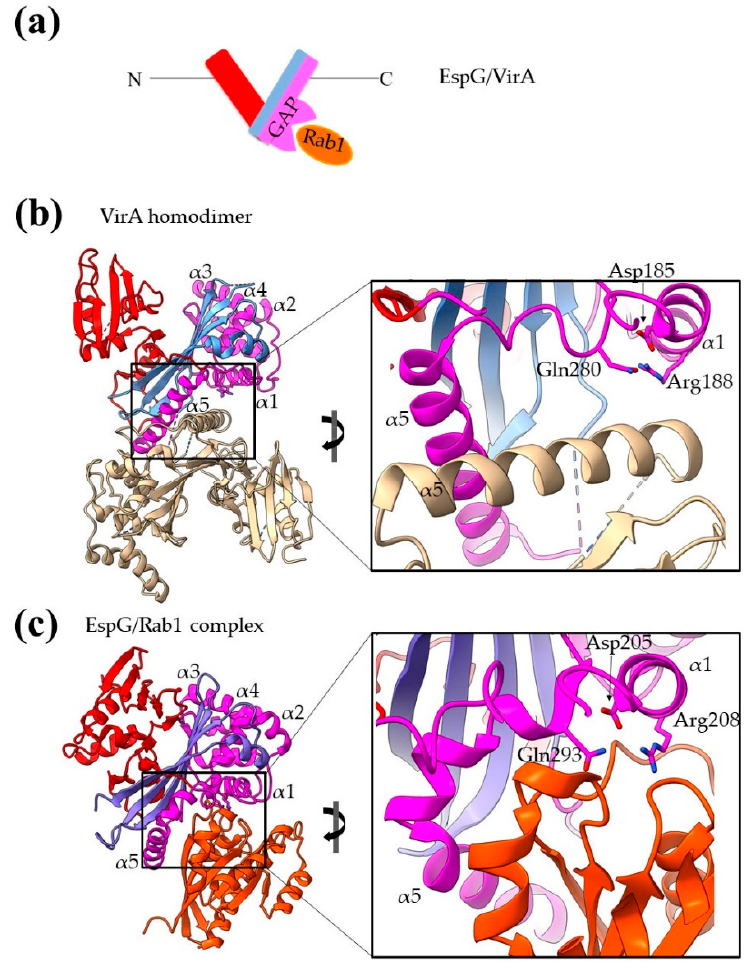
Figure 8. Bacterial structures with GAP activities. ( a ) Schematic representation of the domain architecture of EspG/VirA family members. ( b ) The homodimer of VirA. One monomer is colored white and the other with three different colors highlighting the individual domains. The close-up emphasizes the dimer interface. ( c ) In the EspG/Rab1 complex, the EspG color code is similar to the one used for VirA, and Rab 1 is colored orange. The close-up emphasizes the complex interaction interface and shows that Rab1 binds on a site equivalent to those used for dimerization. MLD stands for membrane localization domain, SS for secretion sequence, CB for chaperone binding.